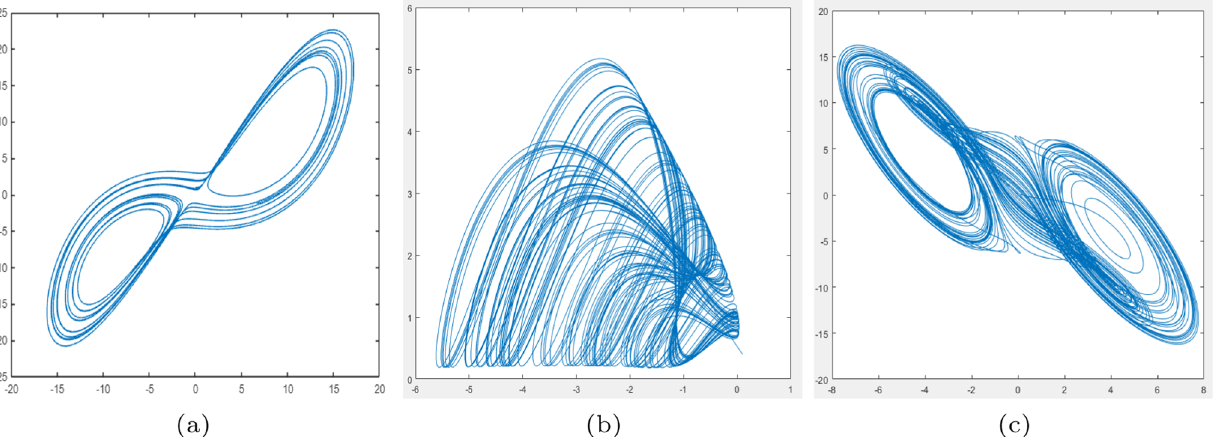
Fig. 12 XSG hardware co-simulation plot for a Lorenz, b (SprottD), and c Chua Table 1 Comparison of resource utilization